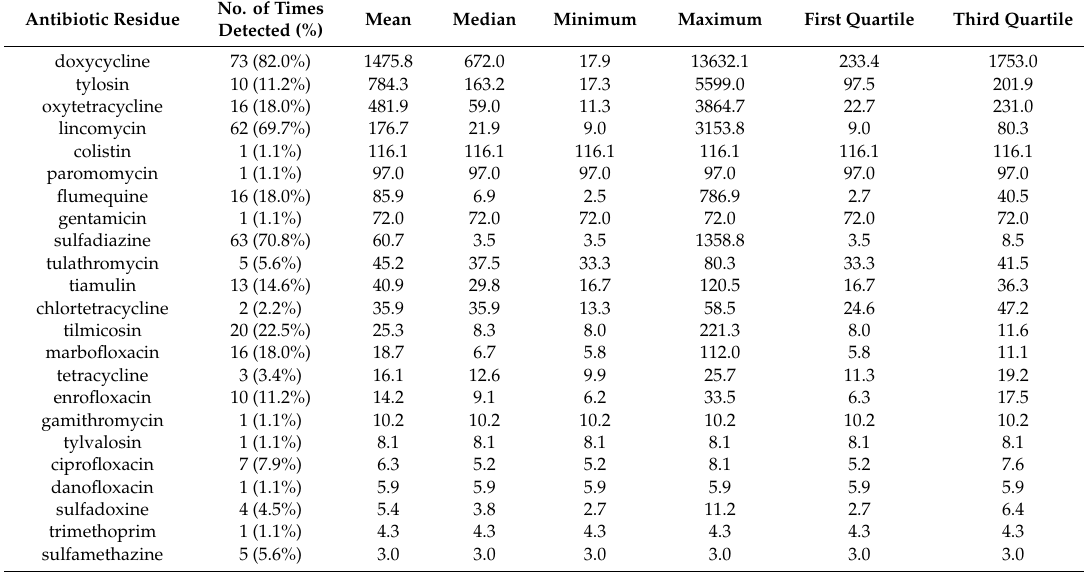
Table 1. Overview of the concentration of the detected antibiotic residues in the pig manure samples where antibiotic residues were detected ( n = 85) (all in µ g / kg).